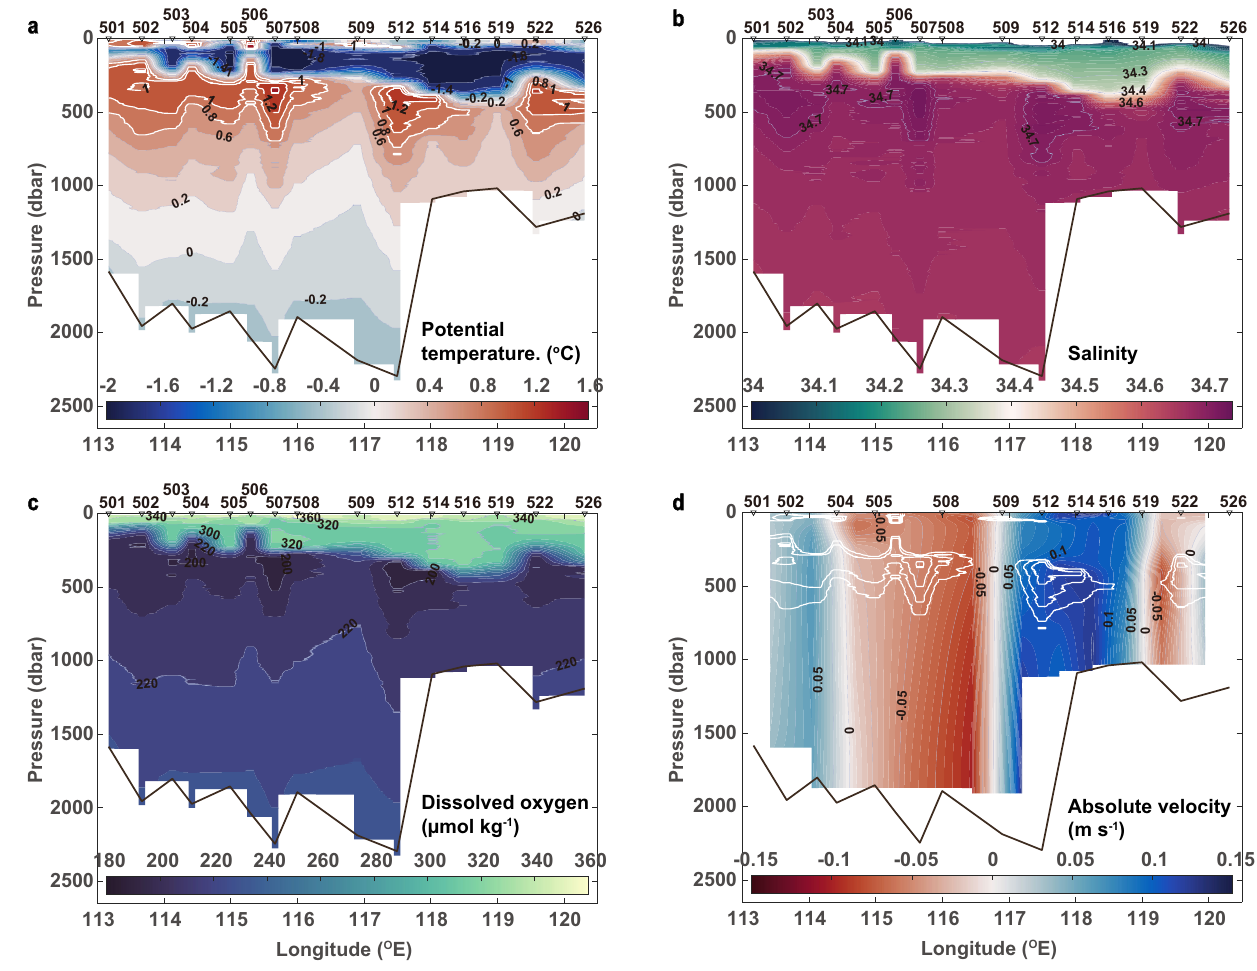
Fig. 3 Poleward eddy-induced warm water transport, toward the shelf break. Zonal hydrographic sections of a potntial temperature (°C), b salinity, c dissolved oxygen ( μ mol kg − 1 ), and d northward absolute velocity (m s − 1 ) along the continental slope (Section 1). In panels a and d , warm cores with potential temperatures higher than 0.8 °C are highlighted in